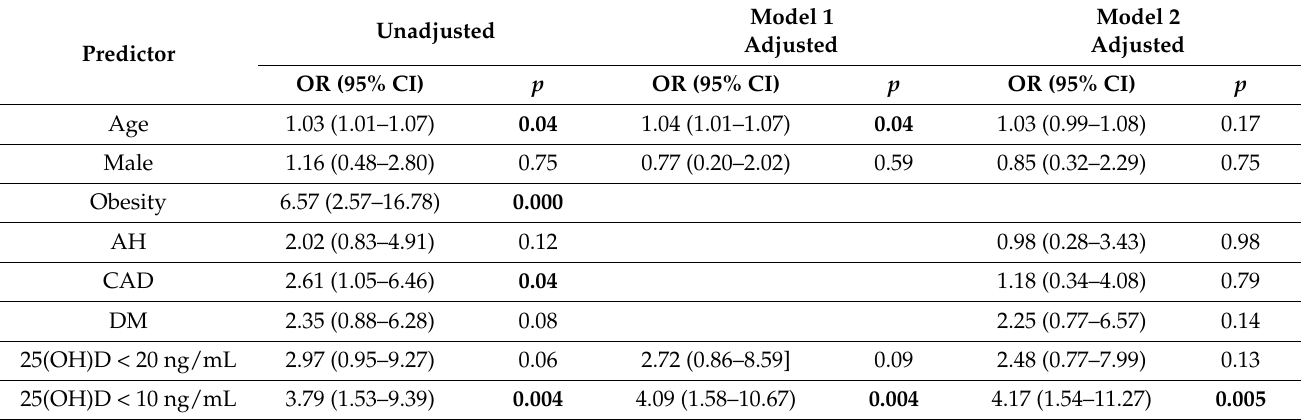
Table 4. Predictors for COVID-19 severity (logistic regression analysis).